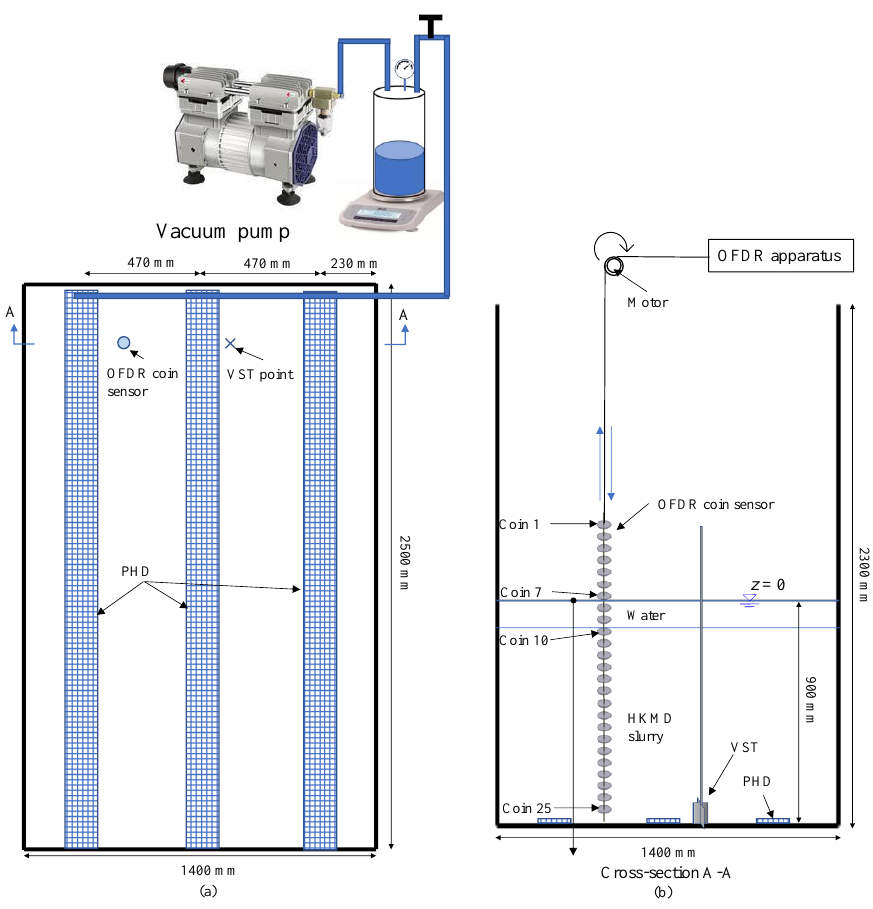
Figure 12. Schematic diagram of the application of the OFDR coin sensor in the large physical model test: ( a ) top view and ( b ) cross-section view.